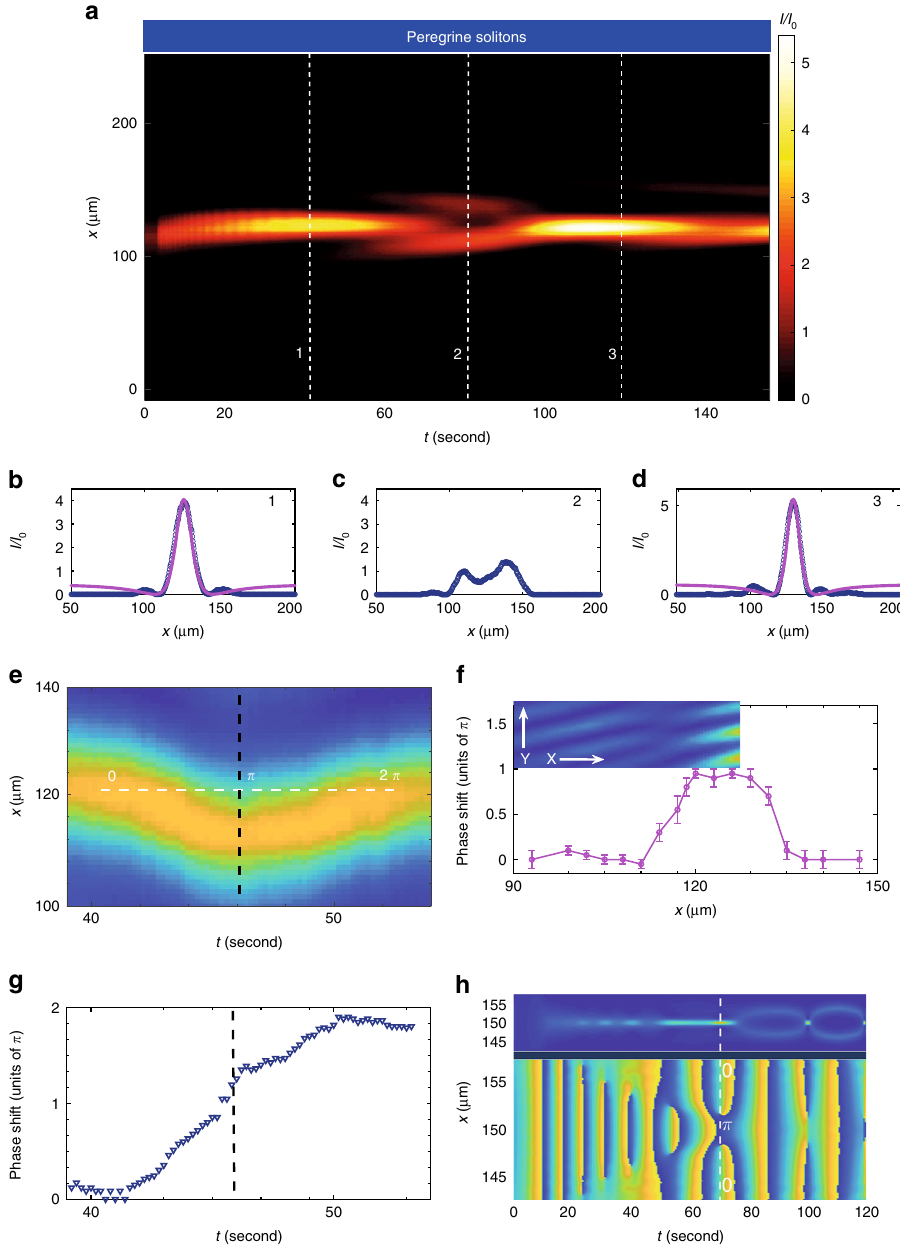
Fig. 5 Experimental topological control for a small waist. a Observation of optical intensity I = I 0 for an initial beam waist W 0 ¼ 30 μ m. Axis t is time of output detection, x is the transverse direction. In this regime, we observe Peregrine-soliton-like structures formation (see Fig. 1b) [the colored scale goes from 0 (dark blue) to 5 (bright yellow)]. c , d Intensity outlines corresponding to numbered dashed lines in ( a ): the blue lines are experimental waveforms, the pink continuous lines are fi tting functions according to the analytical PS pro fi le. e – h Phase measurements ( e – g ) and simulations ( h ) of the Peregrine soliton. The detected interference pattern during the fi rst PS generation is reported in ( e ), corresponding to ( b ). The jump from 0 to 2 π along the white dashed line corresponds to the transition from g ¼ 0 to g ¼ 2. The black dashed line highlights the jump, shown in ( g ). The experimental transversal phase shift pro fi le along x is reported in ( f ), showing the expected π shift corresponding to ( b ). Error bars represent standard deviation. The inset shows the corresponding area of the measured interference fringes on the transverse plane. Phase simulations at W 0 ¼ 10 μ m are reported in the bottom panel in ( h ) [the colored scale goes from (cid:3) π (bright yellow) to π (dark blue) (0 is green)]. Top panel sketches Fig. 4a, for at-a-glance correspondence between genera changes, PS occurrence and phase